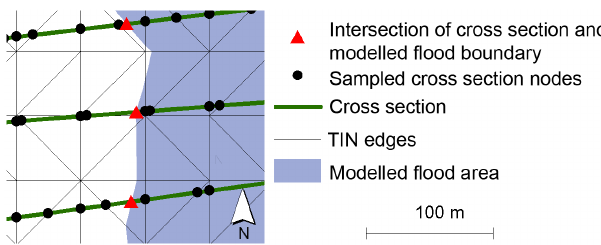
Figure 3. Points sampled at the cross sections intersecting the flood boundary, and nodes at the cross sections intersecting the edges of the TIN